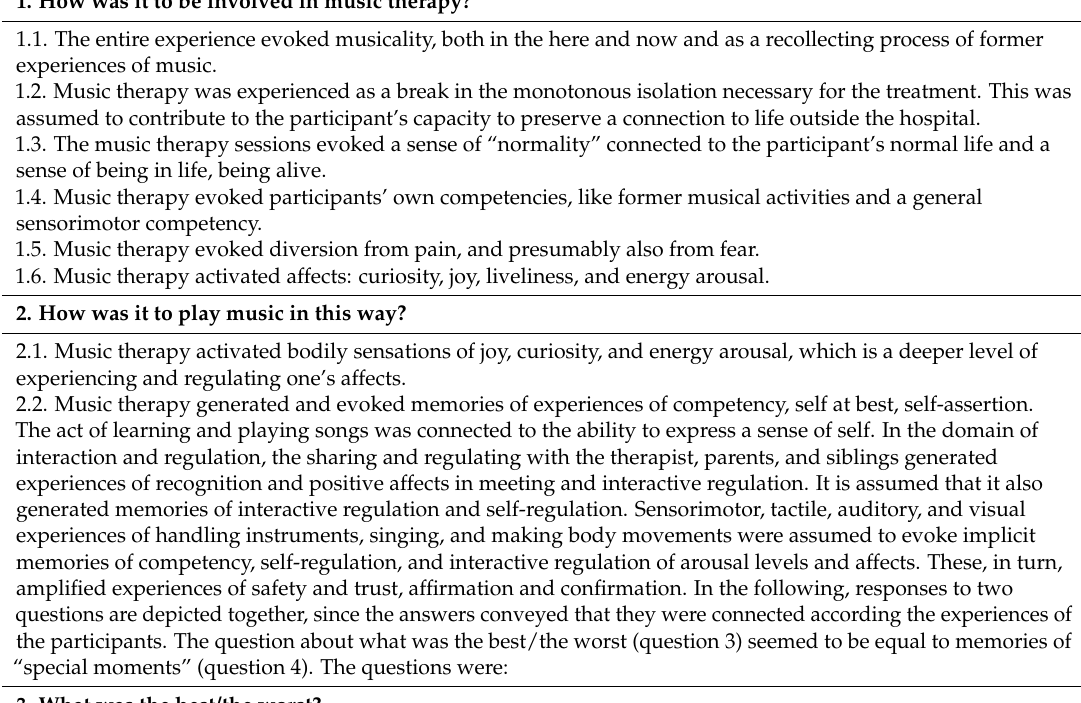
Table A3. Each question is followed by analyzed